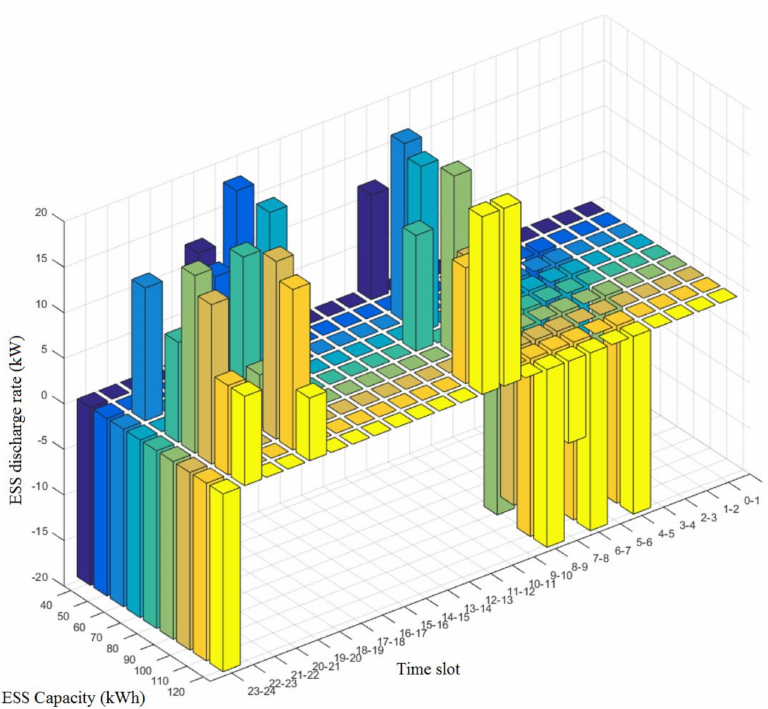
Figure 12. Discharging power by ESS capacity (2).